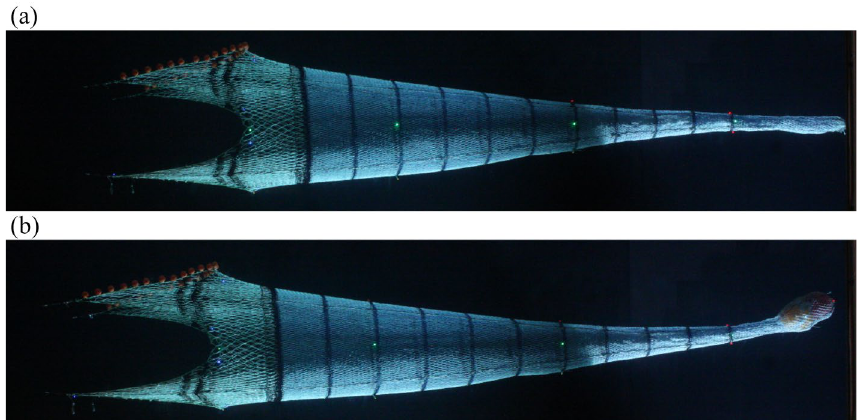
Figure 2. Trawl model with liner in the flume tank of TUMSAT: ( a ) model without catch and ( b ) model with